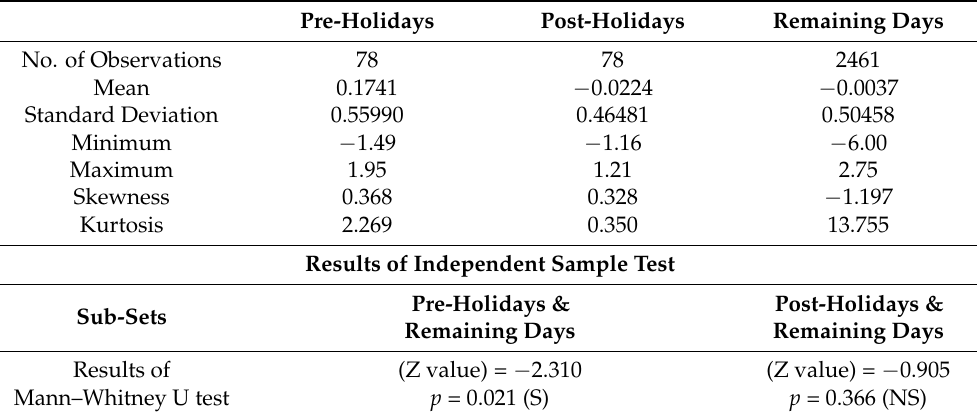
Table 4. The Results of Descriptive Statistics for BHSEASI Daily Returns for Pre, Post-Holiday